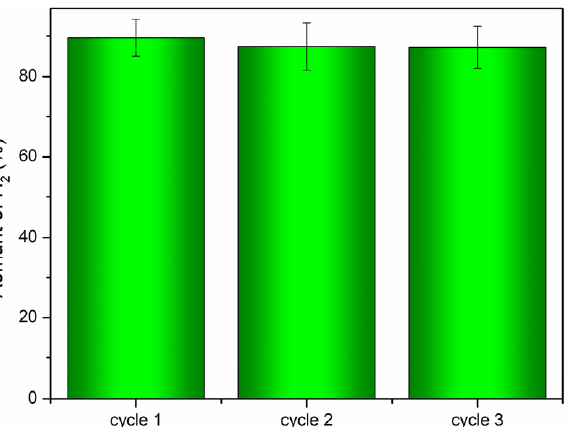
Figure 8. Recycling of the {Ta 6 Br i 12 }@GO-20L photocatalyst in the photochemical H 2 production from water/methanol/HBr in vapor phase after 24 h of irradiation.